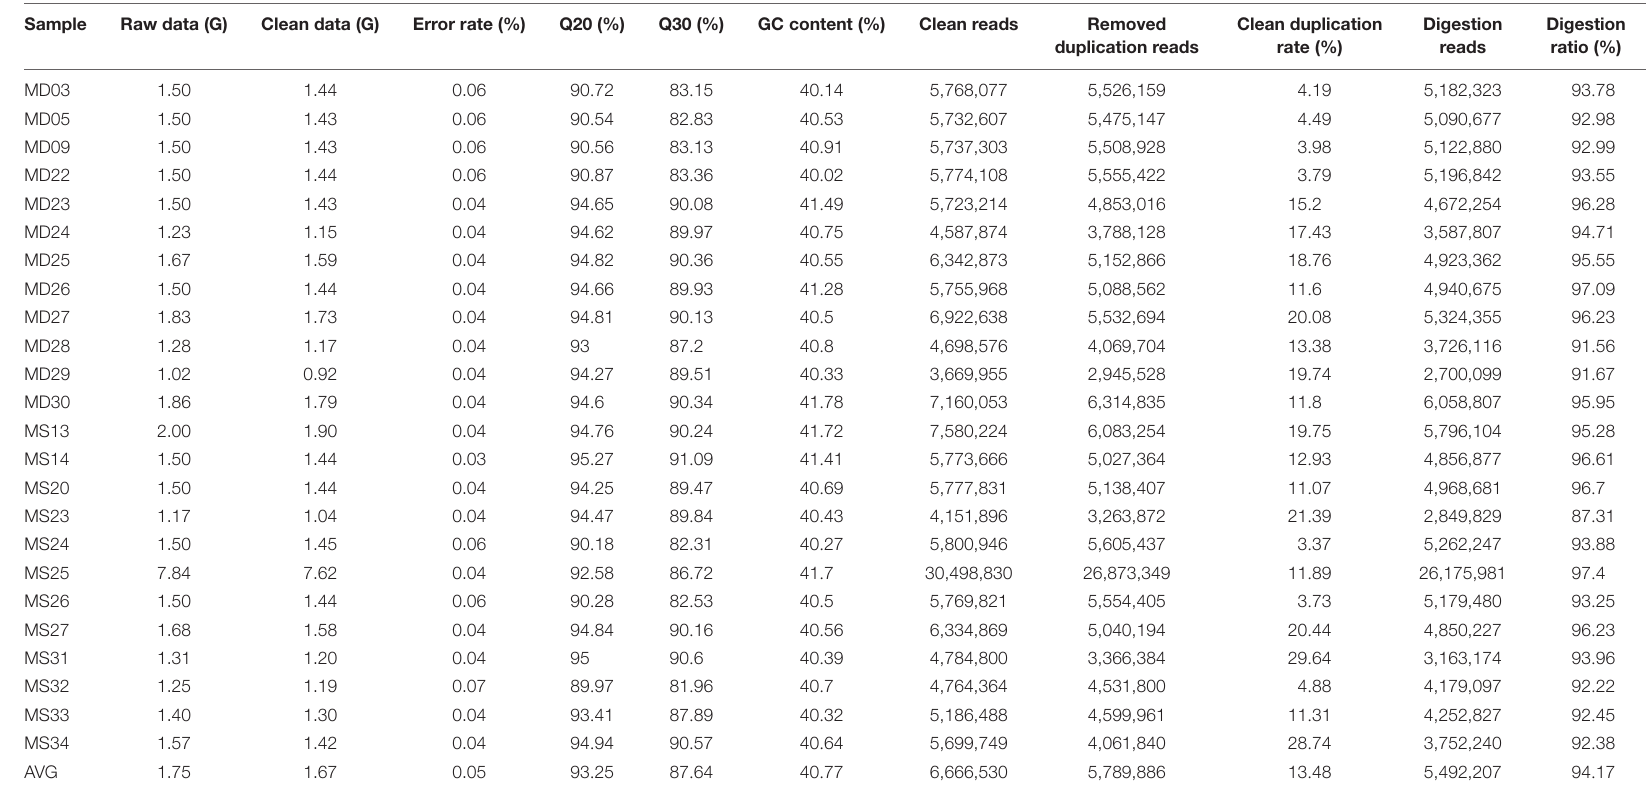
TABLE 1 | Statistics describing the distribution of different properties of RAD sequences after each step of filtering. Sample